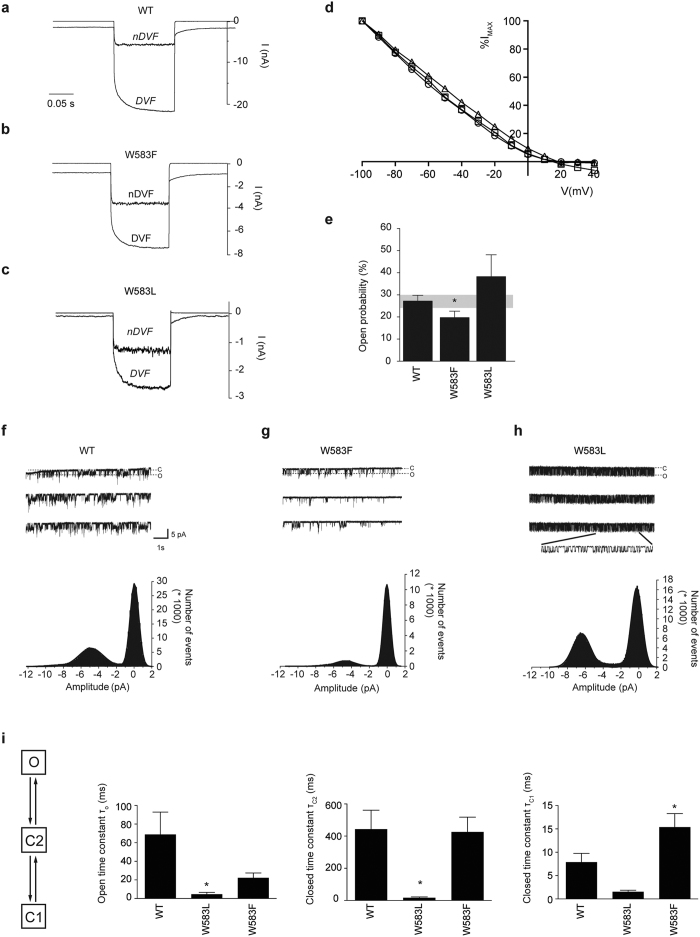
Channel activity is altered in the TRPV5 W583 mutants.(a–c) Representative traces of the whole-cell Na+ currents at the voltage step to −100 mV of HEK293 cells expressing either wild type (WT) TRPV5 or the indicated mutants (W583L and W583F) in nominally DVF (nDVF) and divalent-free (DVF) solutions. (d) Representative current-voltage relationship of wild type (WT) TRPV5 (circle), W583F (triangle), and W583L (square) measured from a voltage step protocol of −100 to + 40 mV in the whole cell configuration in DVF solution and current is depicted as percentage of the maximal current at −100 mV (%Imax). (e) Histogram showing the average open probability at −80 mV for wild type (WT) TRPV5, W583F, and W583L. Values are shown as mean ± SEM (N > 7 per condition). Asterisk indicates statistical significance (p < 0.05) compared to WT. (f–h) Cell-attached single channel recordings were measured during a 10 s step to −80 mV (holding potential 0 mV) in wild type (WT) TRPV5 (f), W583F (g), and W583L (h). Bottom panels show the amplitude histograms with a Gaussian fit function corresponding to the closed and open states in the upper panels. (i) The dwell time constants (τ) are extracted via a three-state model of one open (o) and two closed states (C1 and C2). Average τ values of wild type (WT) TRPV5, W583F, and W583L were derived by two-exponential fit of the model-based distribution of dwell times, obtained from single channel recordings (N > 7). Values are shown as mean ± SEM. Asterisk indicates statistical significance (p < 0.05) compared to WT.